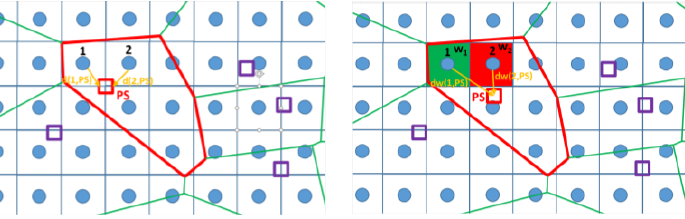
Figure 15. Example of weighted Voronoi diagram approach for PS location.